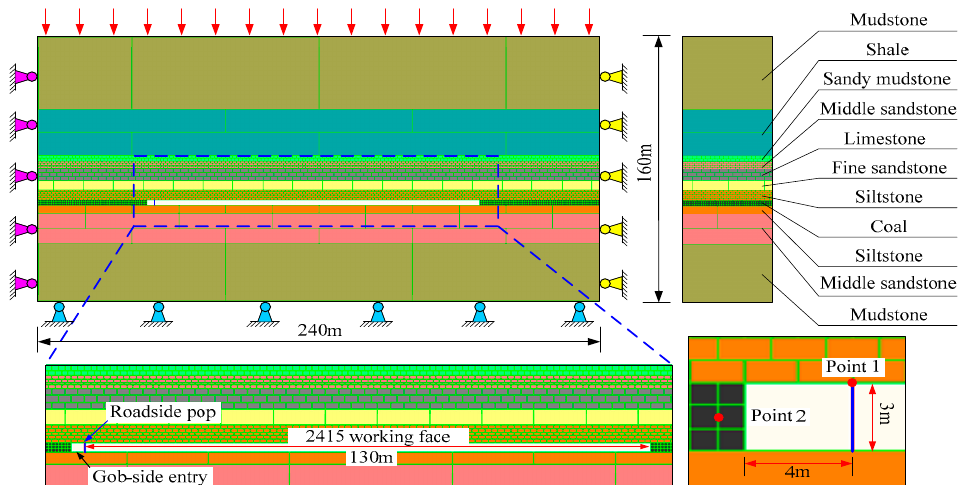
Figure 8. Numerical model and boundary conditions.